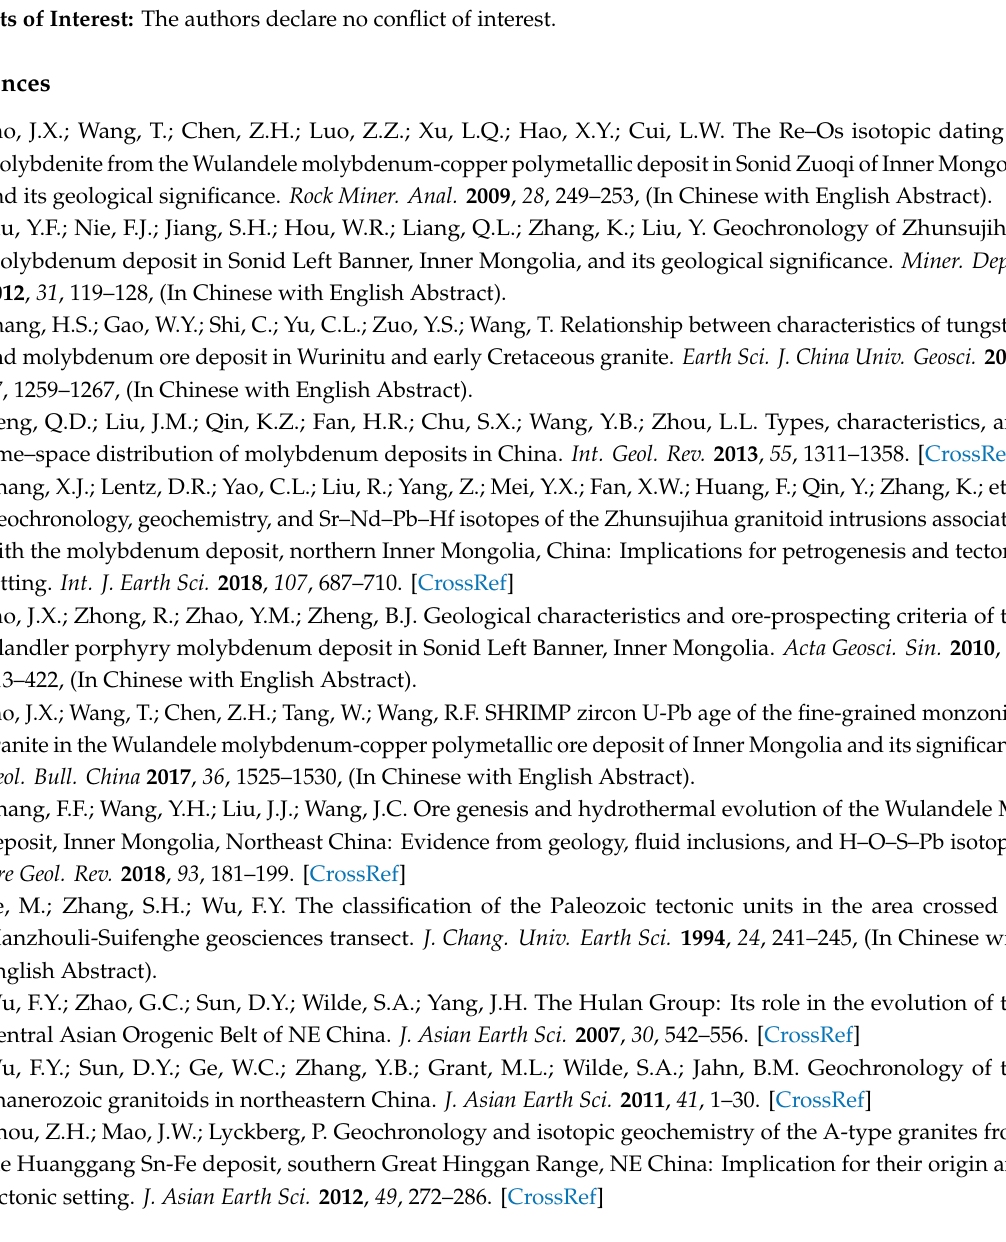
Table S1: Re-Os data for molybdenite samples from the Wulandele Mo deposit; Table S2: Major element contents and relative parameters of the MG from the Wulandele Mo deposit; Table S3: Trace element contents and relative parameters of the MG from the Wulandele Mo deposit; Table S4: Sr-Nd-Pb isotopic compositions of the MG from the Wulandele Mo deposit